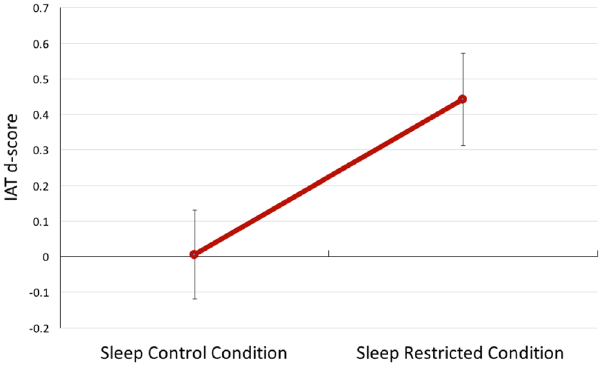
Figure 2. This figure represents the estimated marginal means with standard error ( ± 1 SE) bars for IAT d-scores for the sleep control (n = 15) and sleep restricted conditions (n =